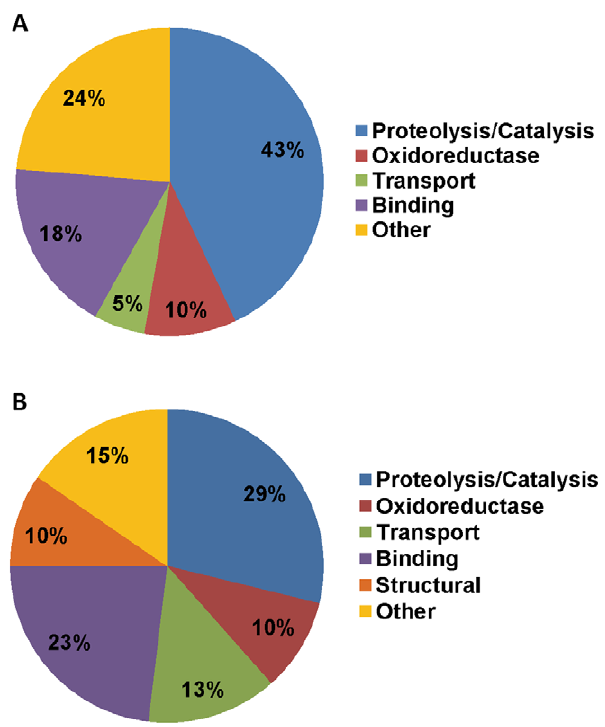
Figure 1. Gene Ontology molecular function categories of Aedes aegypti seminal fluid and putative sperm proteins. A. Seminal fluid proteins; B. Putative sperm proteins.